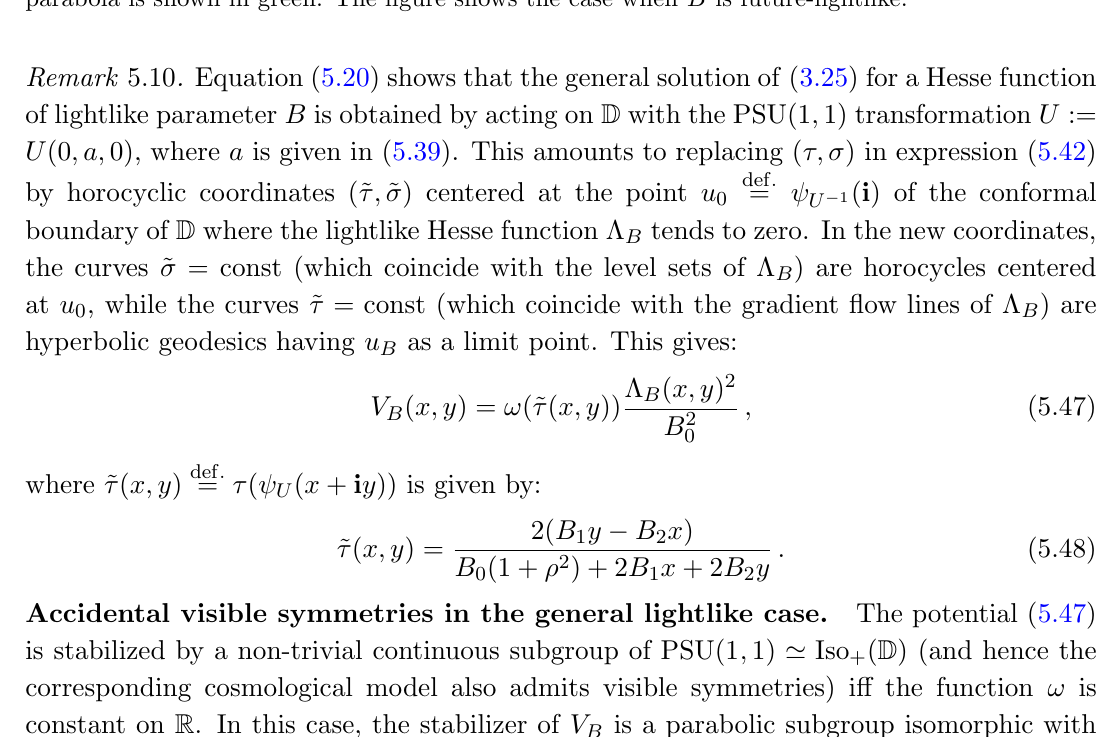
Figure 11. The lightlike vector n B ( u ) (shown in gray) determined by (cid:4)( u ) (shown in red) and by a lightlike 3-vector B (shown in blue), where the 3-vector (cid:4) B ( u ) is shown in orange. As u varies in D, the vector n B ( u ) describes the parabola (shown in gray) obtained by intersecting the light cone with the plane de(cid:12)ned in Minkowski 3-space by the equation ( X; B ) = 1; one can think of the function ! as being de(cid:12)ned on this parabola. The 3-vector n 0 corresponding to the apex of this parabola is shown in green. The (cid:12)gure shows the case when B is